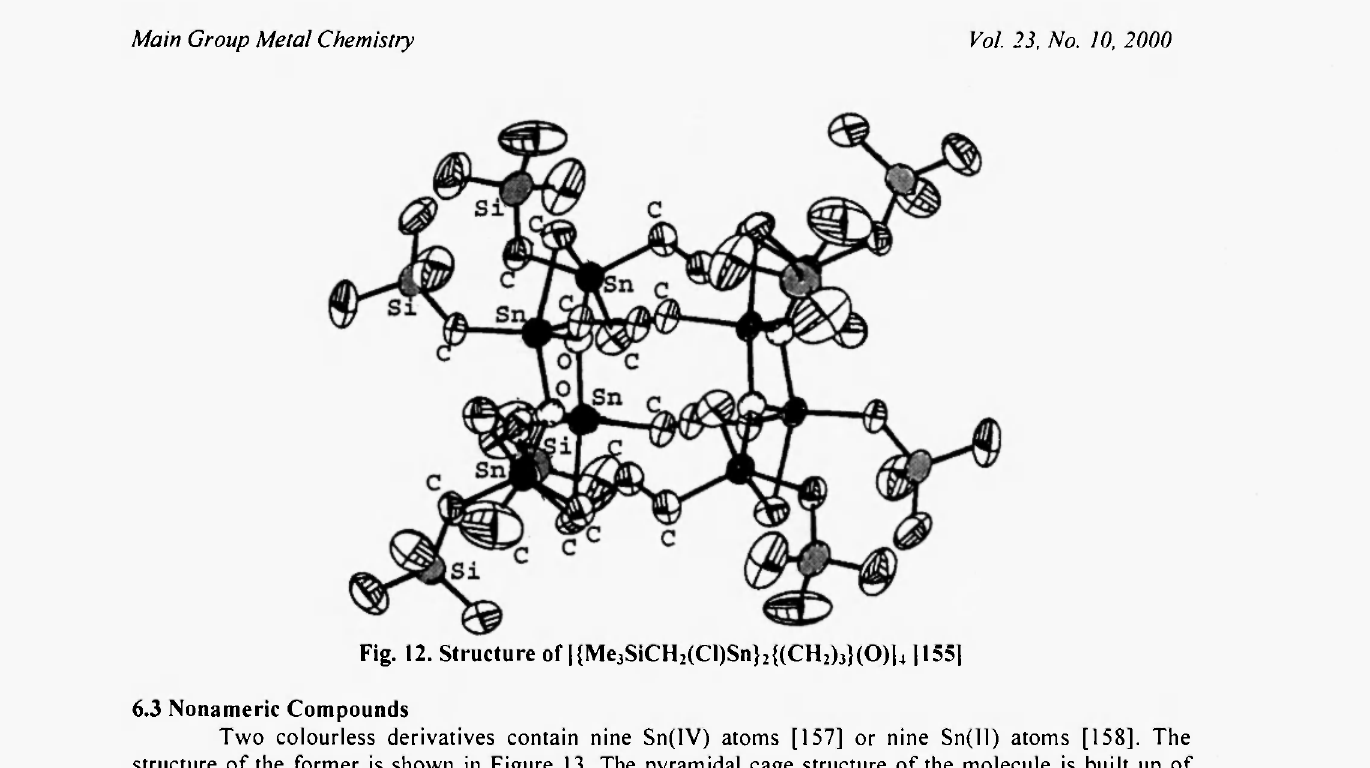
Fig. 12. Structure of |{Me 3 SiCH 2 (CI)Sn} 2 {(CH 2 )j}(0)| 4 |155|